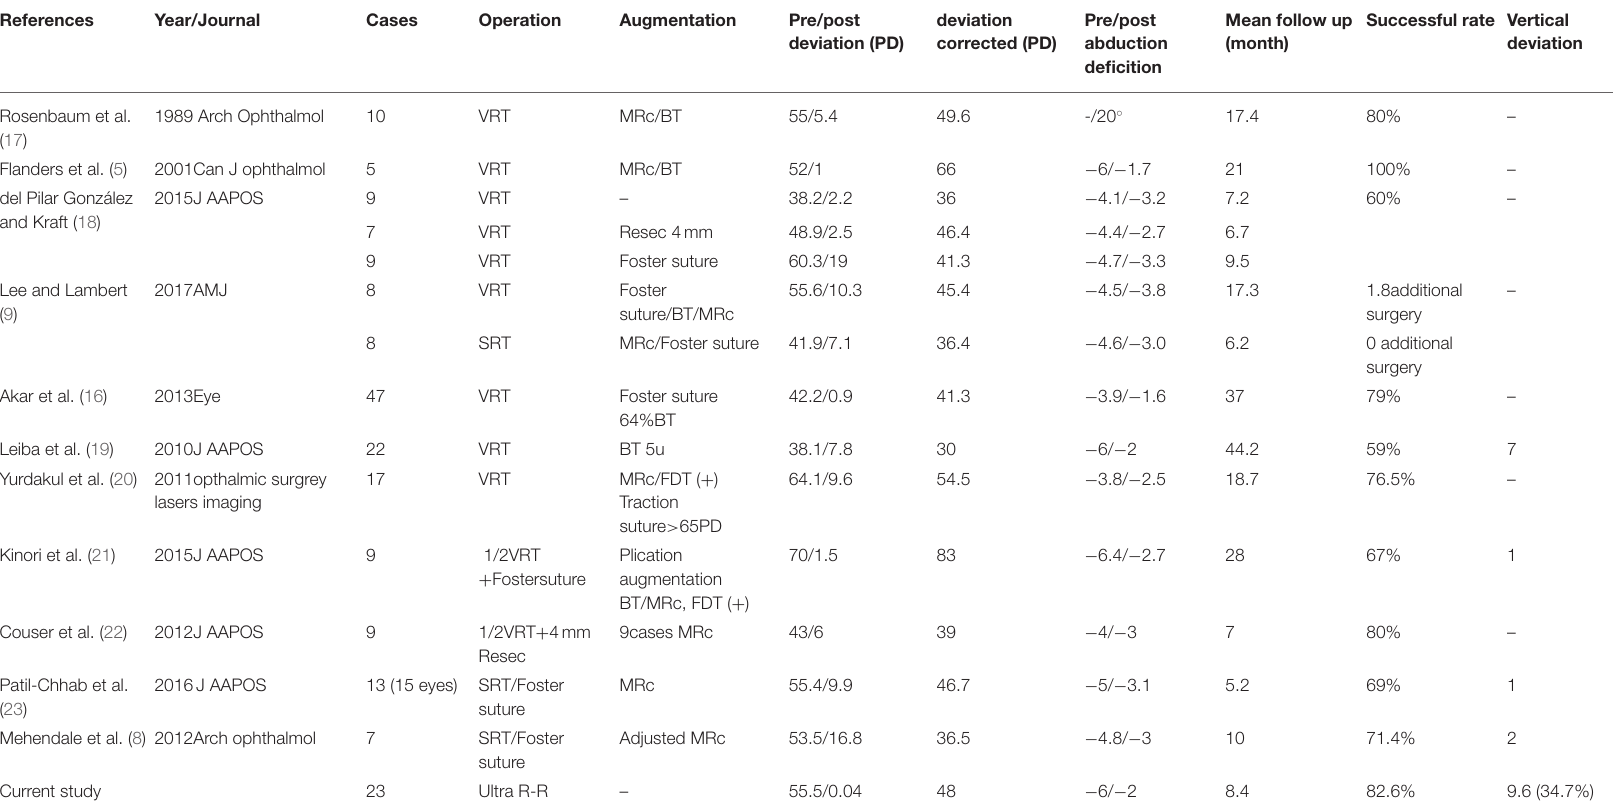
TABLE 7 | Comparison of supramaximal–RR surgery with previous SRT and VRT procedures for abducens nerve palsy